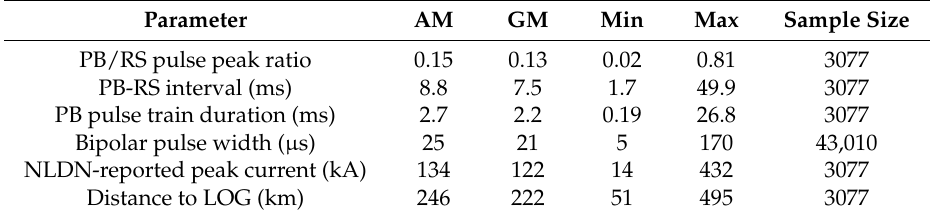
Table 1. Characterization of PB pulses in 3077 negative flashes each containing a single PB pulse train.